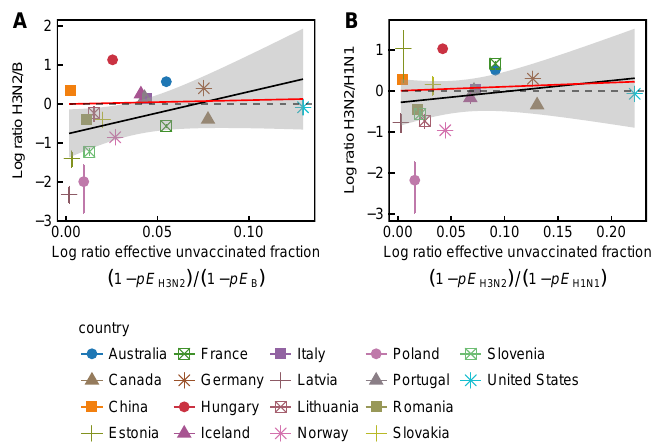
Figure A13. Country-level differences in subtype ratios of countries are not consistent with vaccine-driven selection, accounting for vaccine effectiveness. ( A ) the ratio of H3N2 to B among countries does not significantly correlate with the theoretical ratio (Pearson’s r = 0.21, p = 0.40); ( B ) similarly, the ratio of H3N2 to H1N1 among countries correlates significantly with the theoretical ratio (Pearson’s r = 0.50, p = 0.04). Theoretical ratios are calculated using Canadian VEs [27–34] for the Northern Hemisphere and Australian VEs for the Southern Hemisphere [24–26]. Error bars show 95% confidence intervals estimated using multinomial distributions of seasonal subtype frequencies. Red line shows expectation based on Equation (A23). The number of seasons contributing to each data point is shown in Figure A14.